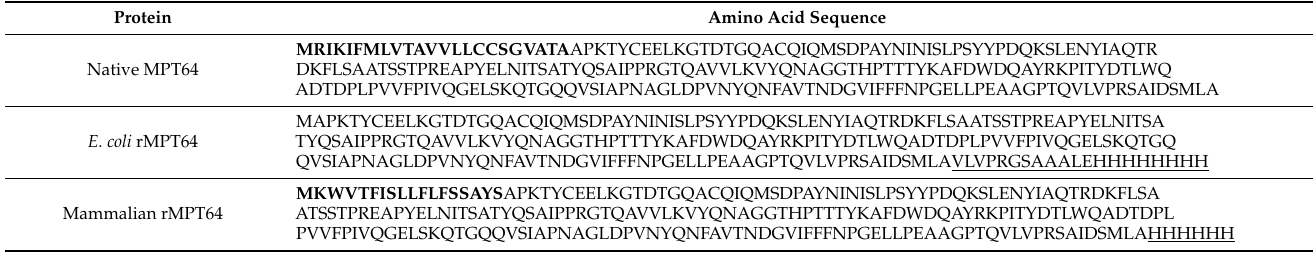
Table 1. Amino acid sequence of the various forms of MPT64 protein used as antigen in the study. The native MPT64 sequence is derived from M. bovis BCG Moreau and includes a N-terminal cleavable protein secretion signal sequence (bold), which is not present in the final, secreted form of the protein. The sequence of the recombinant protein produced in Escherichia coli ( E. coli rMPT64) includes a C-terminal Thrombin-cleavable 8XHis-tag (underlined) to simplify purification. The sequence of the recombinant protein produced in human HEK cells (mammalian rMPT64) includes a N-terminal HSA signal peptide (bold) to secrete the protein, and a C-terminal 6XHis-tag (underlined) to simplify purification. Protein Amino Acid Sequence